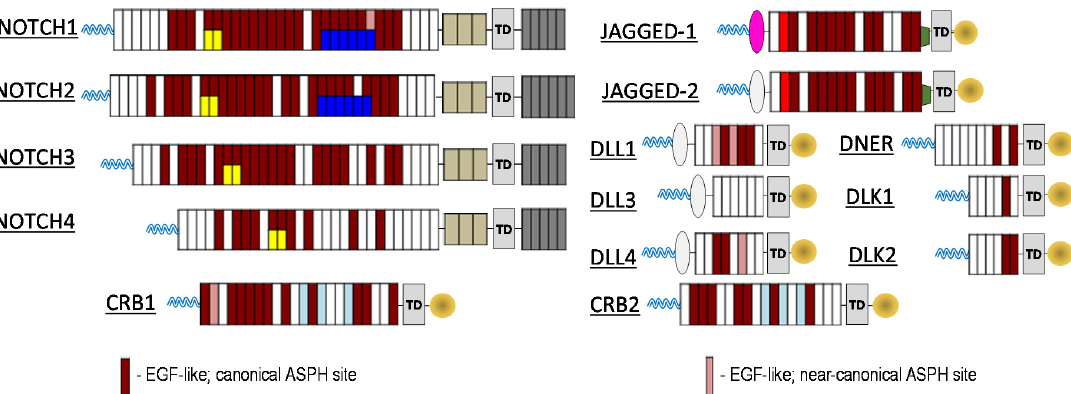
Figure 1. Presence of multiple canonical Aspartyl(asparaginyl)- β -hydroxylase (ASPH) hydroxylation sites in all cbEGF containing NOTCH receptors, ligands (JAGGED-1/2) and modulators such as Crumbs human homologs.